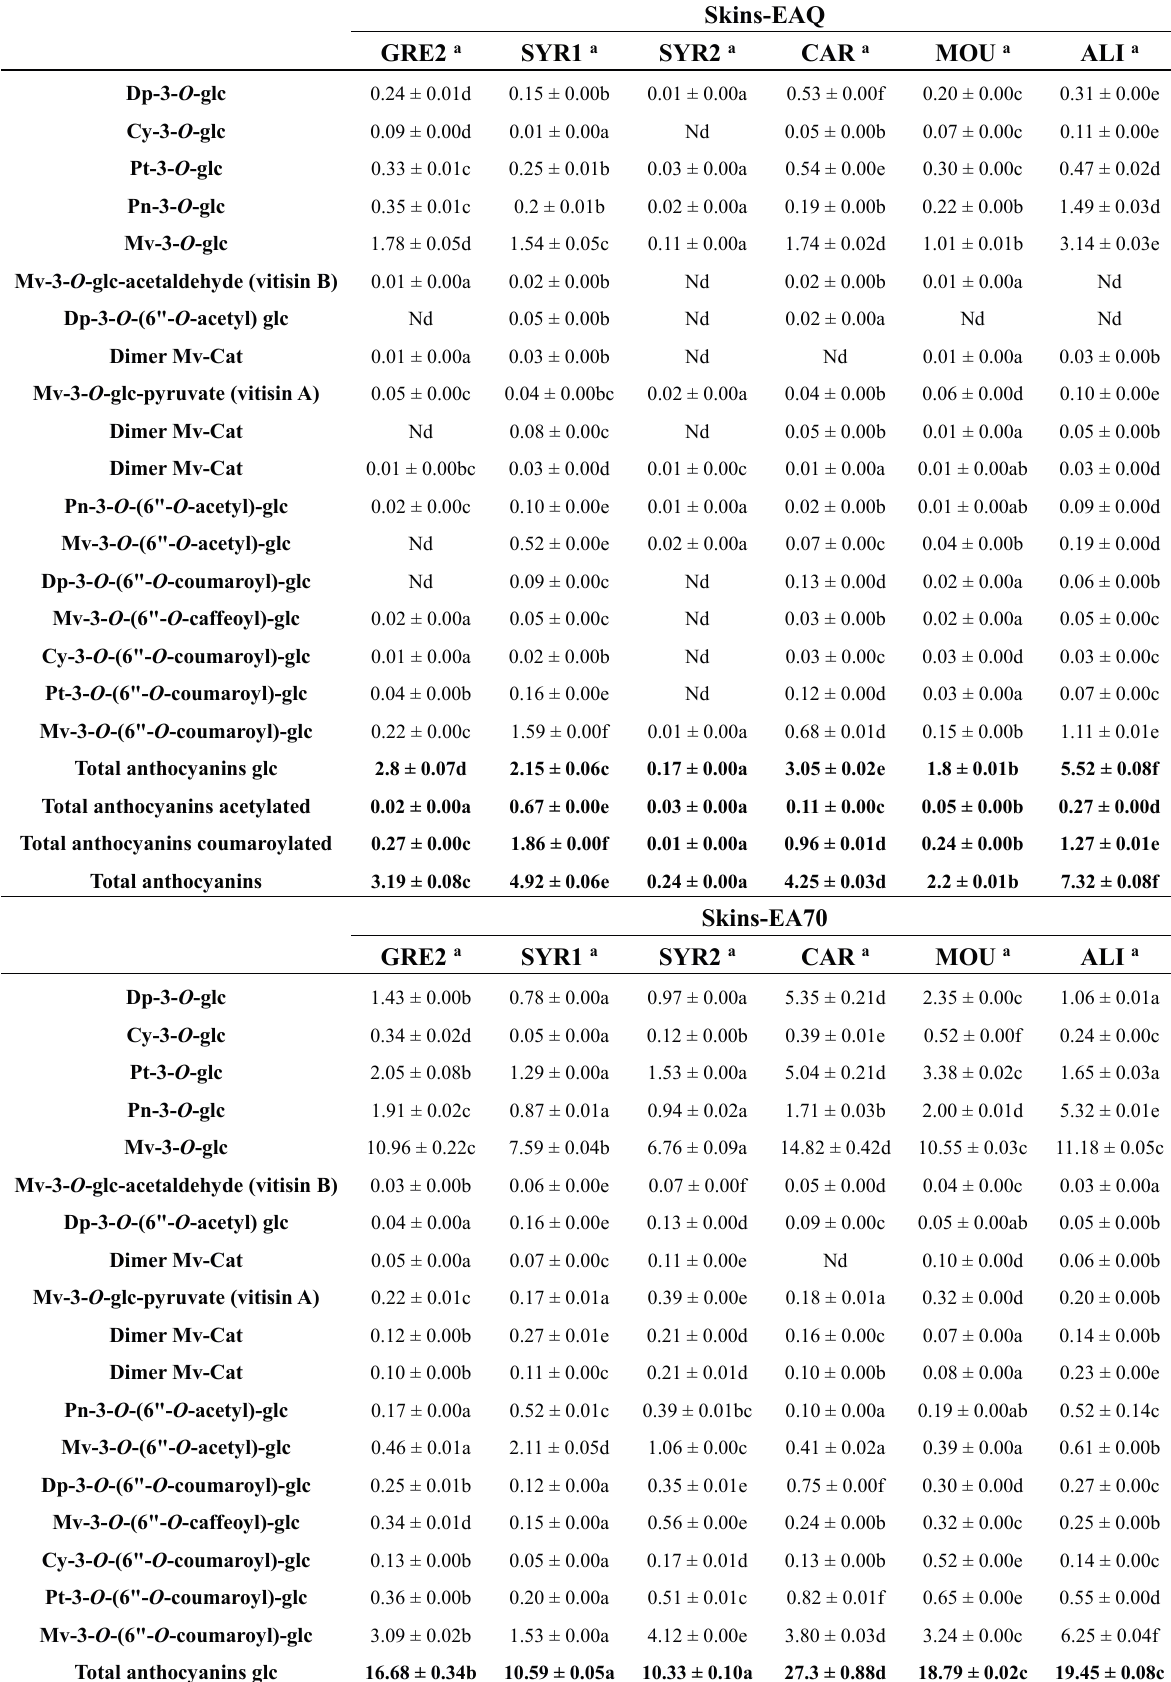
Table 4. Anthocyanin characterisation in EAQ and EA70 grape pomace skin extracts.